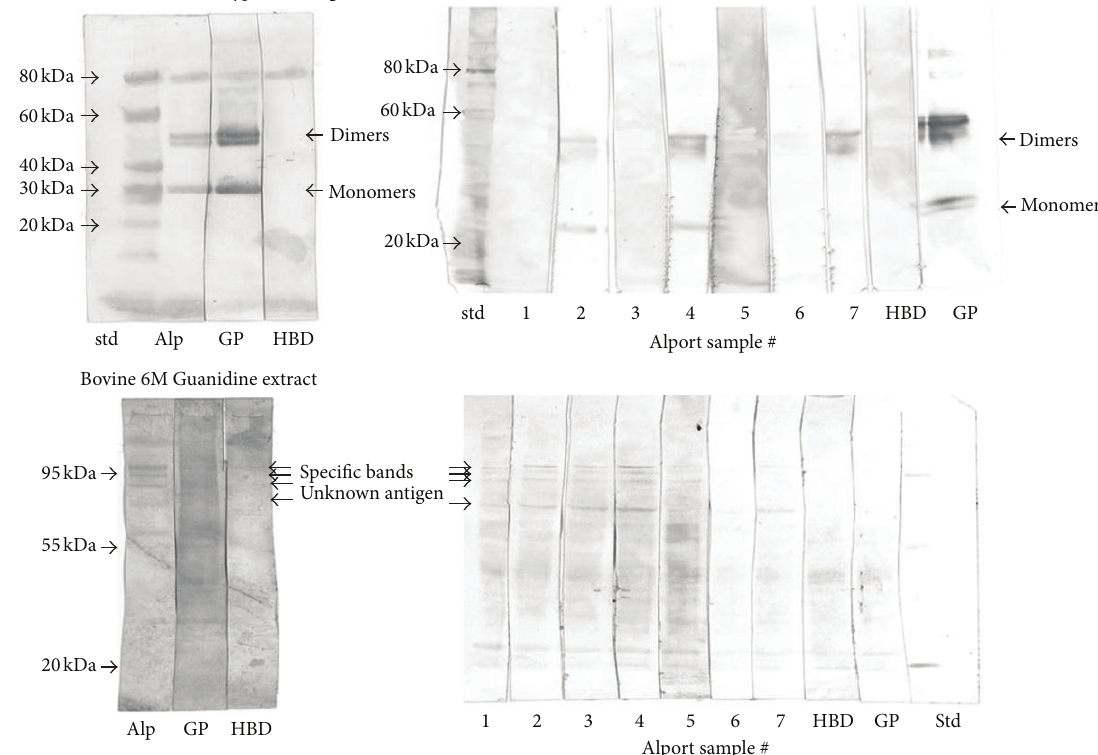
Figure 3: Western blots using purified bovine NC-1 domain of type IV collagen (upper 2 panels) and crude guanidine extract of bovine glomerular basement membrane (lower 2 panels). Sample 1:2 months after transplantation. Sample 2: 1 week after transplantation.